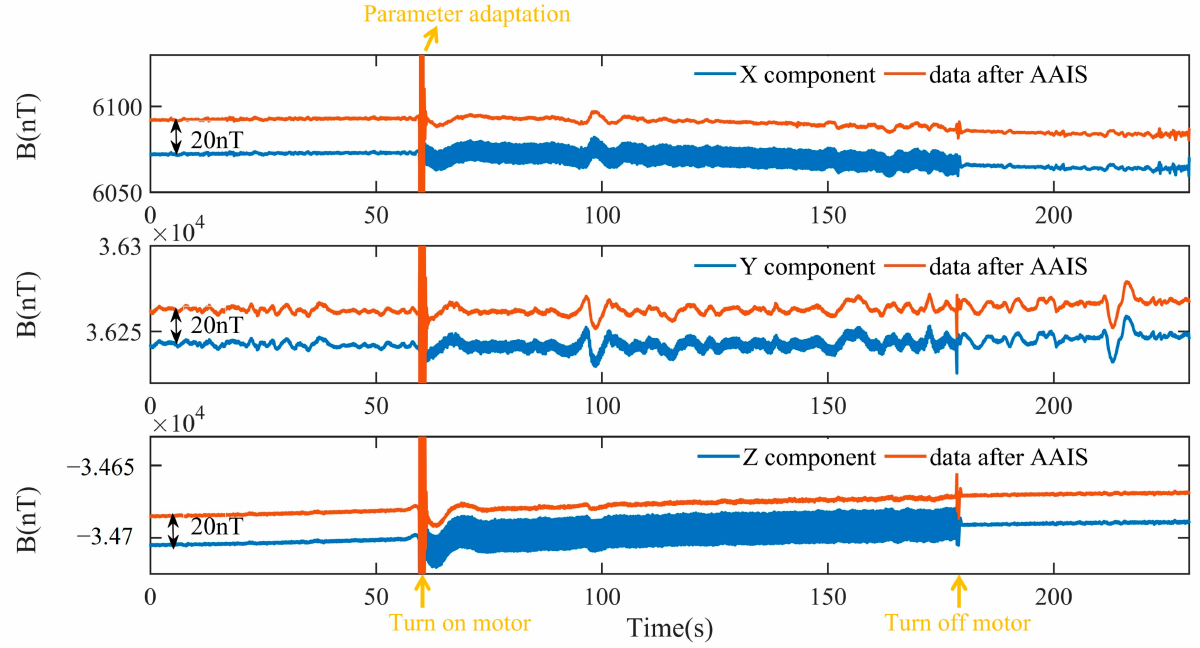
Figure 9. In static experiments, the components of the magnetic field before and after